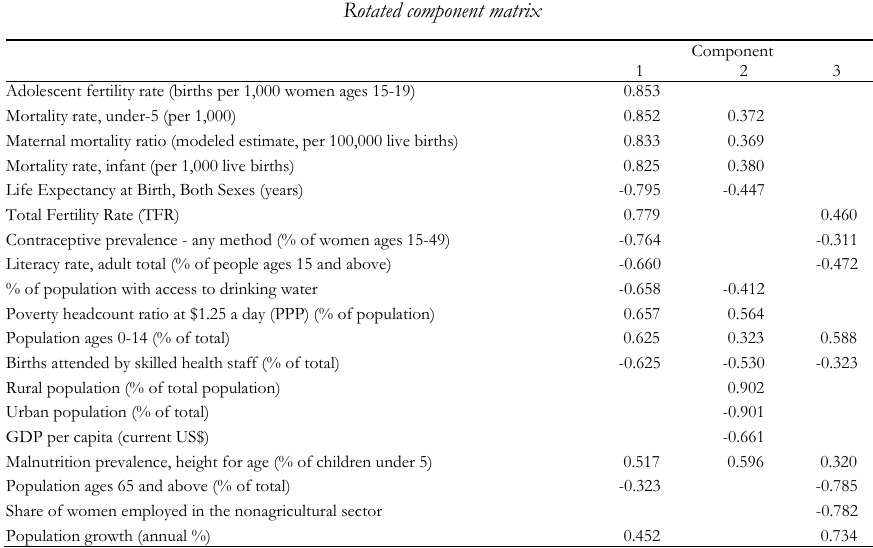
Rotated component